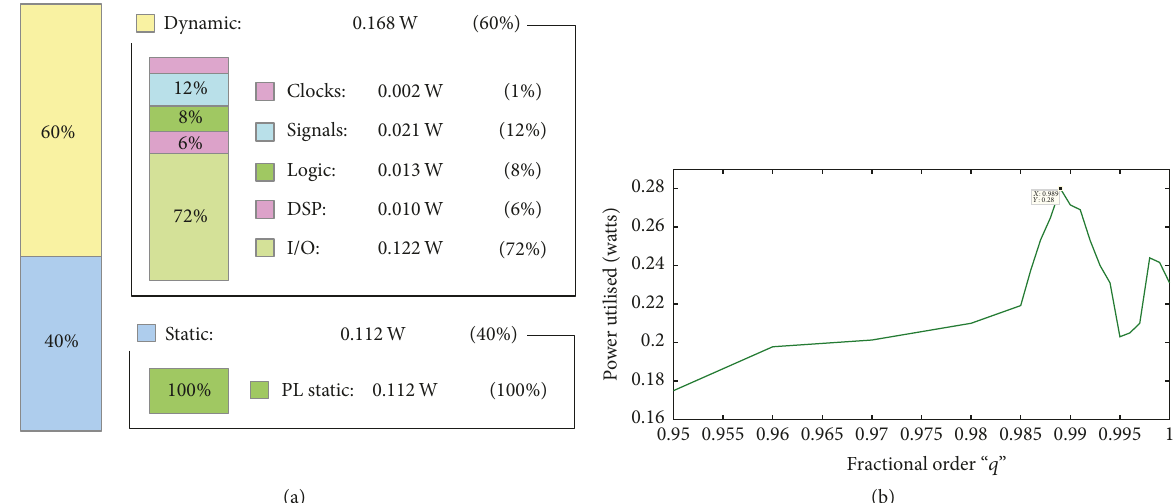
Figure 24: (a) Power utilized and (b) power utilization versus fractional order of FONCS-1 system.